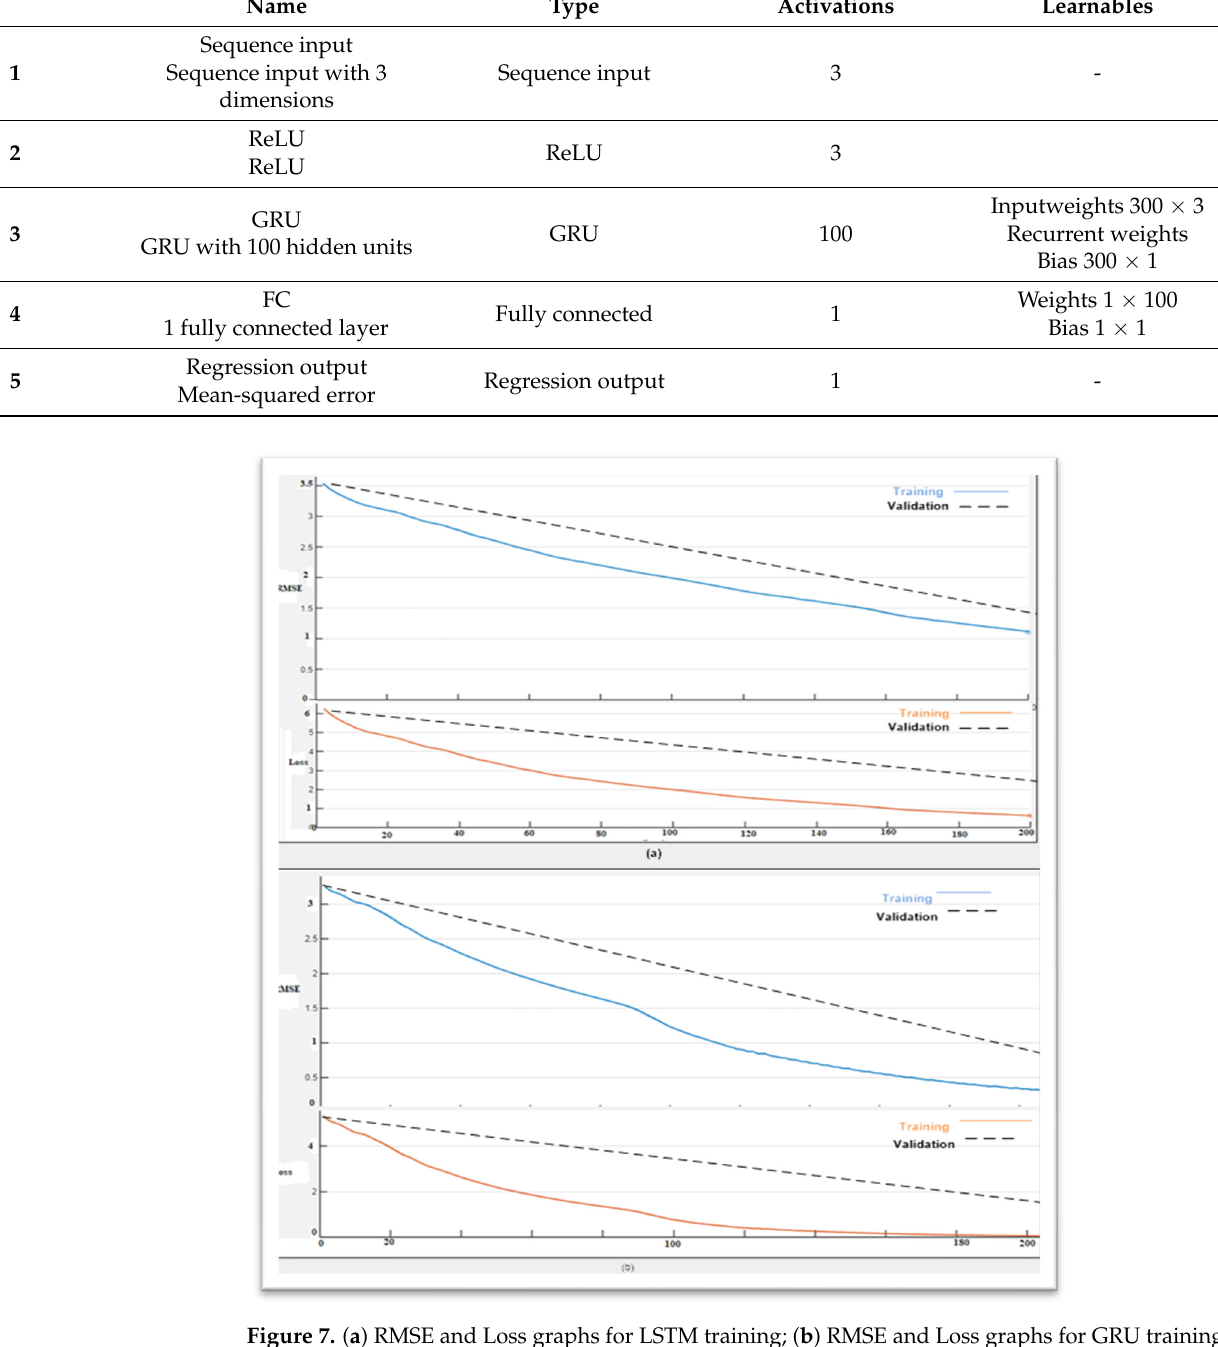
Figure 7. ( a ) RMSE and Loss graphs for LSTM training; ( b ) RMSE and Loss graphs for GRU training.